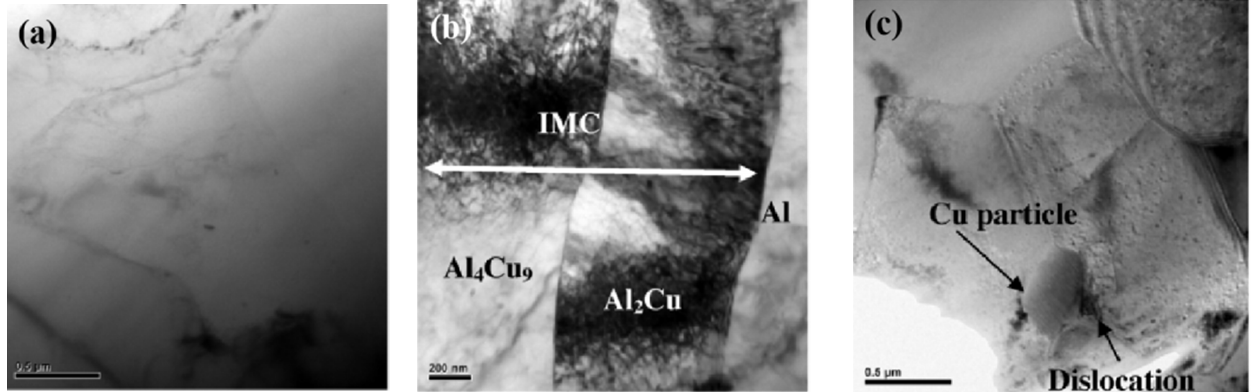
Figure 17. TEM investigation of the various regions of the stir zone microstructure at the tool travel speed of 80 mm/min: ( a ) SZ (Cu side); ( b ) intermetallic layer; and ( c ) SZ (Al side) (from ref. [54]).